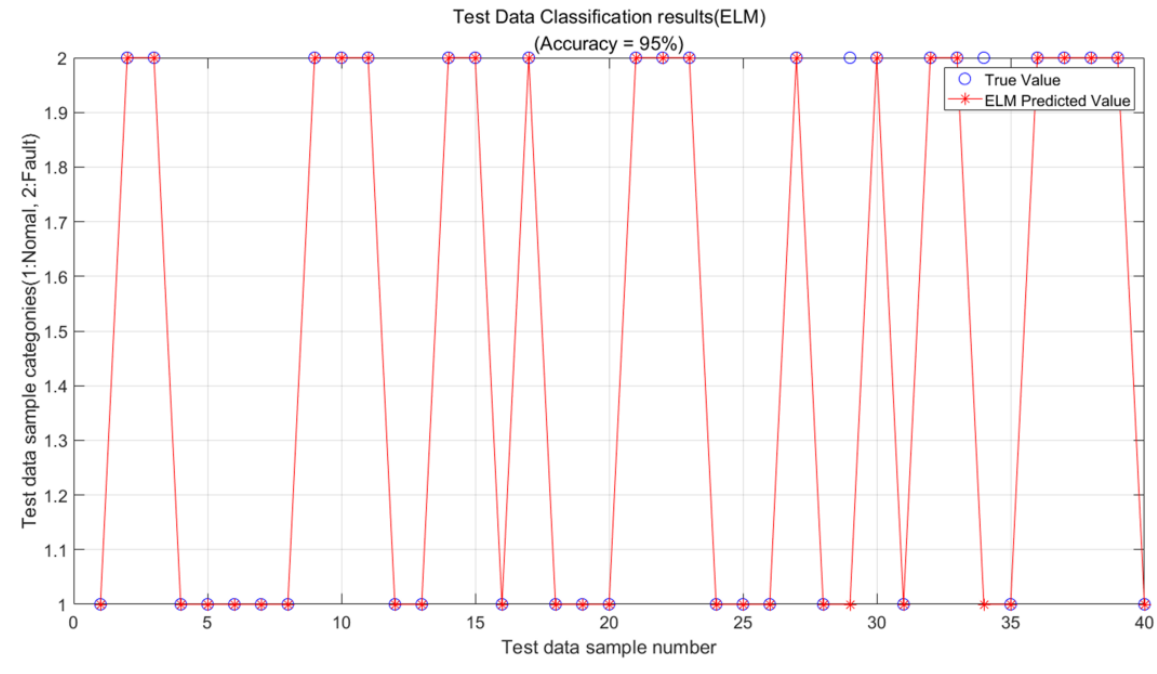
Figure 11. Comparison of the predicted and true values of the test data(ELM).